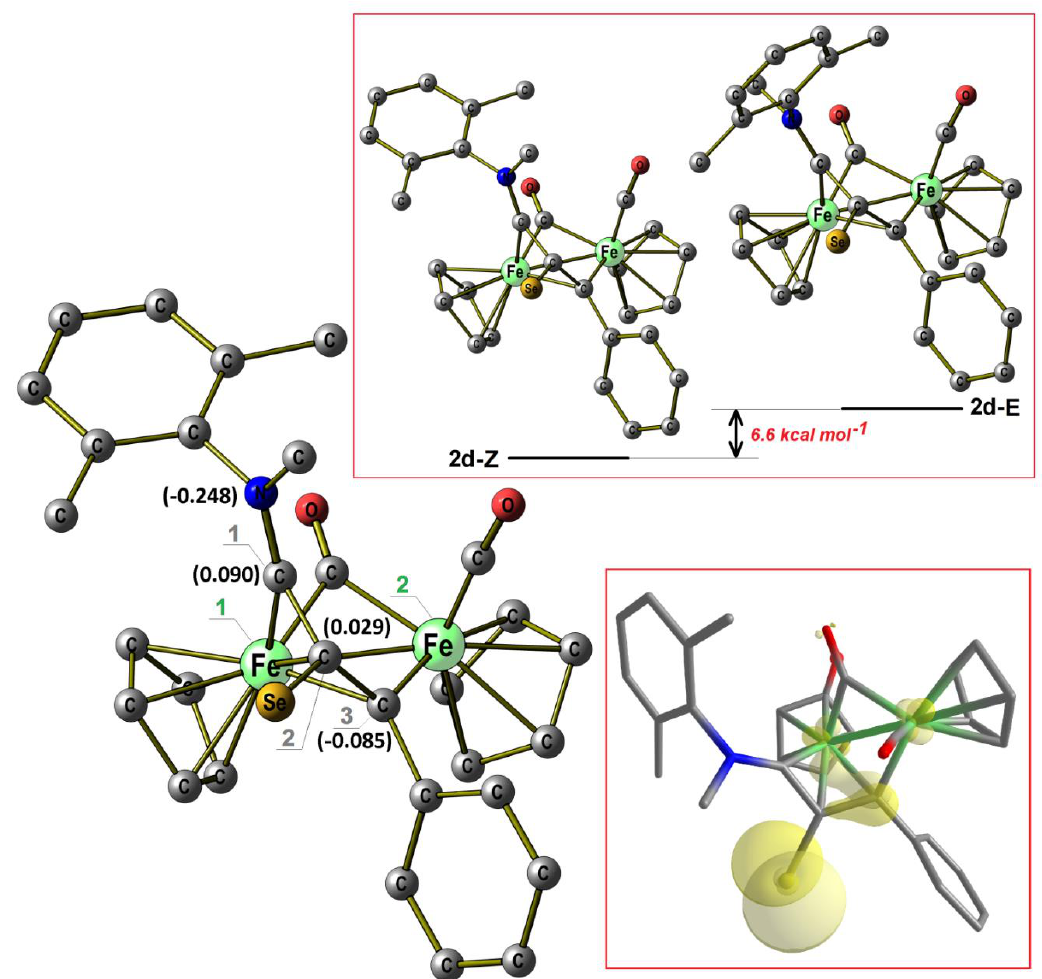
Figure 2. DFT-optimized structure of 2d , Z isomer (C-PCM / ω B97X / def2-SVP calculation, chloroform as continuous medium). Hydrogen atoms are omitted for clarity. Selected computed bond lengths